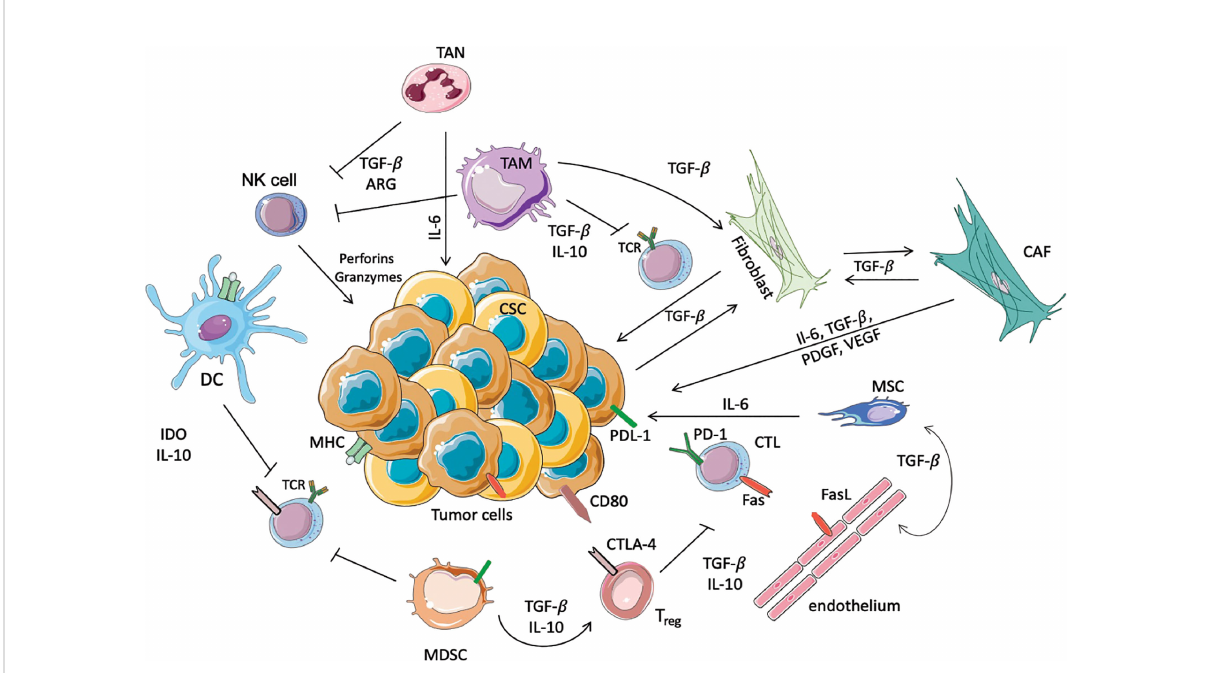
FIGURE 1 Schematic representation of immunosuppressive cells in the TME. In this scheme the major immune cells involved in the anti-tumor or pro- tumor response are highlighted. TANs and TAMs secrete TGF- b , Il-10 and ARG-I, which inhibit the cytotoxic activity of NK cells and T cells. Moreover, TAMs promote the conversion of normal fi broblasts into CAFs, which in turn promote the proliferation of tumor cells. In this immunosuppressive microenvironment DCs, through the secretion of IL-10 and overexpression of IDO, prevent the activation of T cells, avoiding the recognition of the tumoral antigens expressed on MHC. Another immunosuppressive population is represented by MDSCs that inhibit the activation of T cells, and furthermore allow the activation of Tregs, in particular increasing the expression of CTLA4 on the surface of Treg themselves. Moreover, Tregs inhibit the cytotoxic functionality of the CTLs, where PD-1 and Fas are increased to inhibit the anti-tumoral response. Finally, the endothelium contributes to immunosuppression, since these cells express